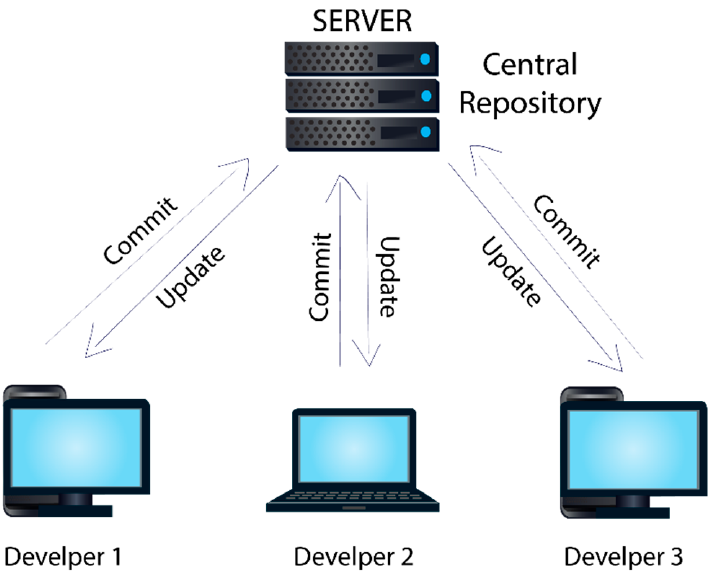
Figure 2. Tradition version control.